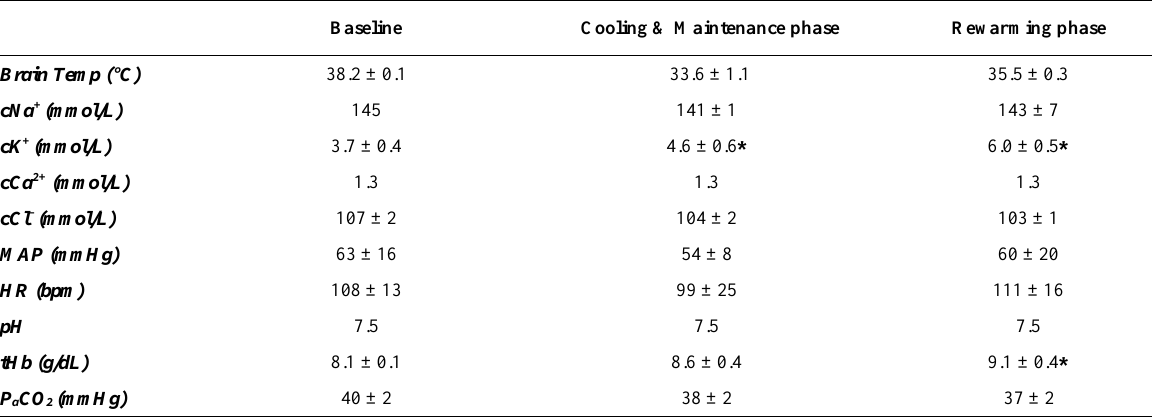
Table 1. Physiological parameters (mean  standard deviation (SD)) measured at different brain temperatures at baseline and during cooling and rewarming. cNa + - sodium concentration, cK + - potassium concentration, cCa + - calcium concentration, cCl - - chloride concentration, tHb - total hemoglobin concentration, and P a CO 2 - partial pressure of carbon dioxide was measured in arterial blood samples. MAP - mean arterial pressure - HR - heart rate was measured from a femoral artery catheter. *A statistically significant (p<0.05) change compared to baseline Baseline Cooling & Maintenance phase Rewarming phase 38.2 ± 0.1